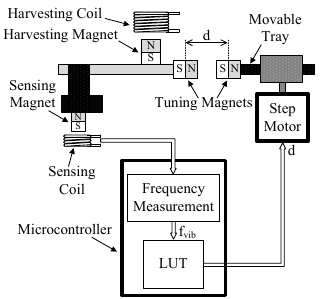
Figure 10. Schematic representation of the magnetic forces based MTT proposed in [11].